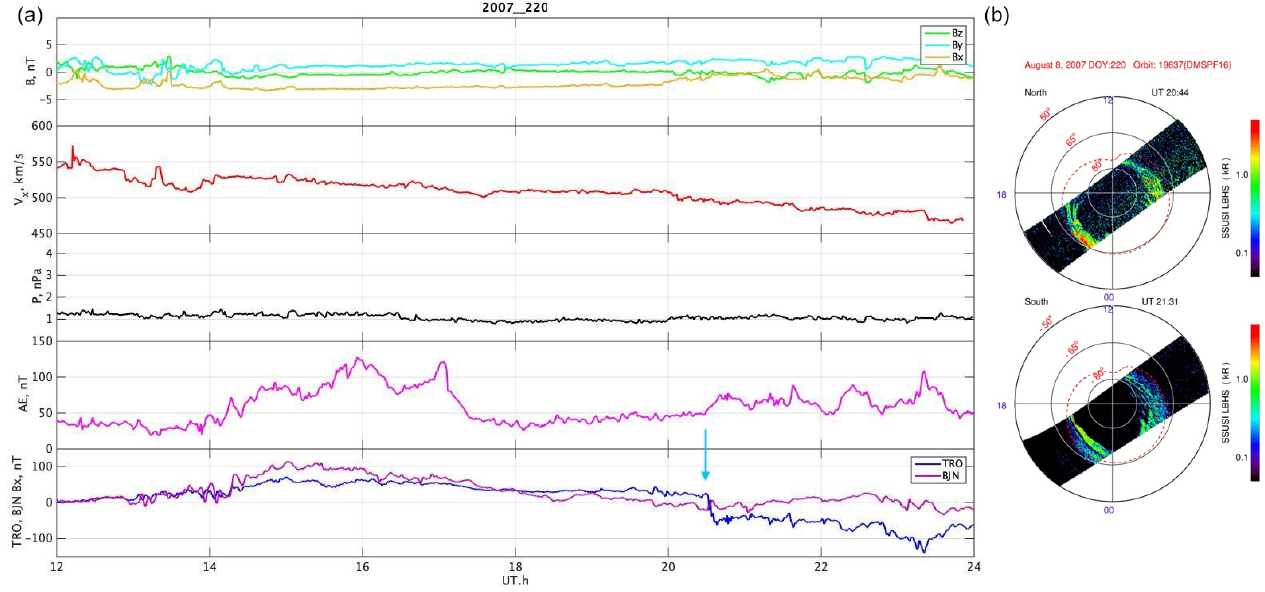
Figure 2. Panel (b) presents the particle precipitation seen from the DMSP satellite data. Panel (a) shows the solar wind parameter and ground-based magnetometer data including, from top to bottom, all IMF components, SW speed, SW pressure, the AE index, and the magnetic field data from the TRO and BJN stations. A small substorm is marked using the vertical blue arrow.